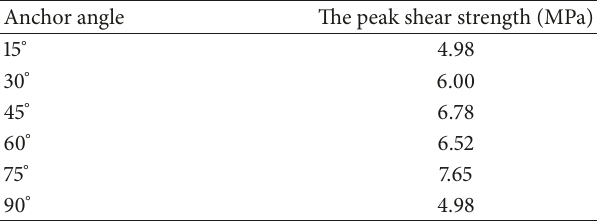
Table 3: Peak shear strength for different anchorage angles. Anchor